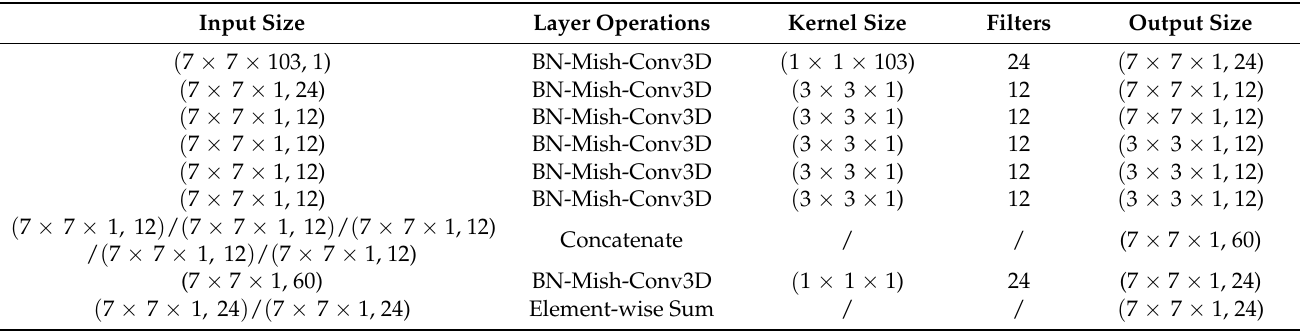
Table 2. Detailed steps of the spatial one-shot dense